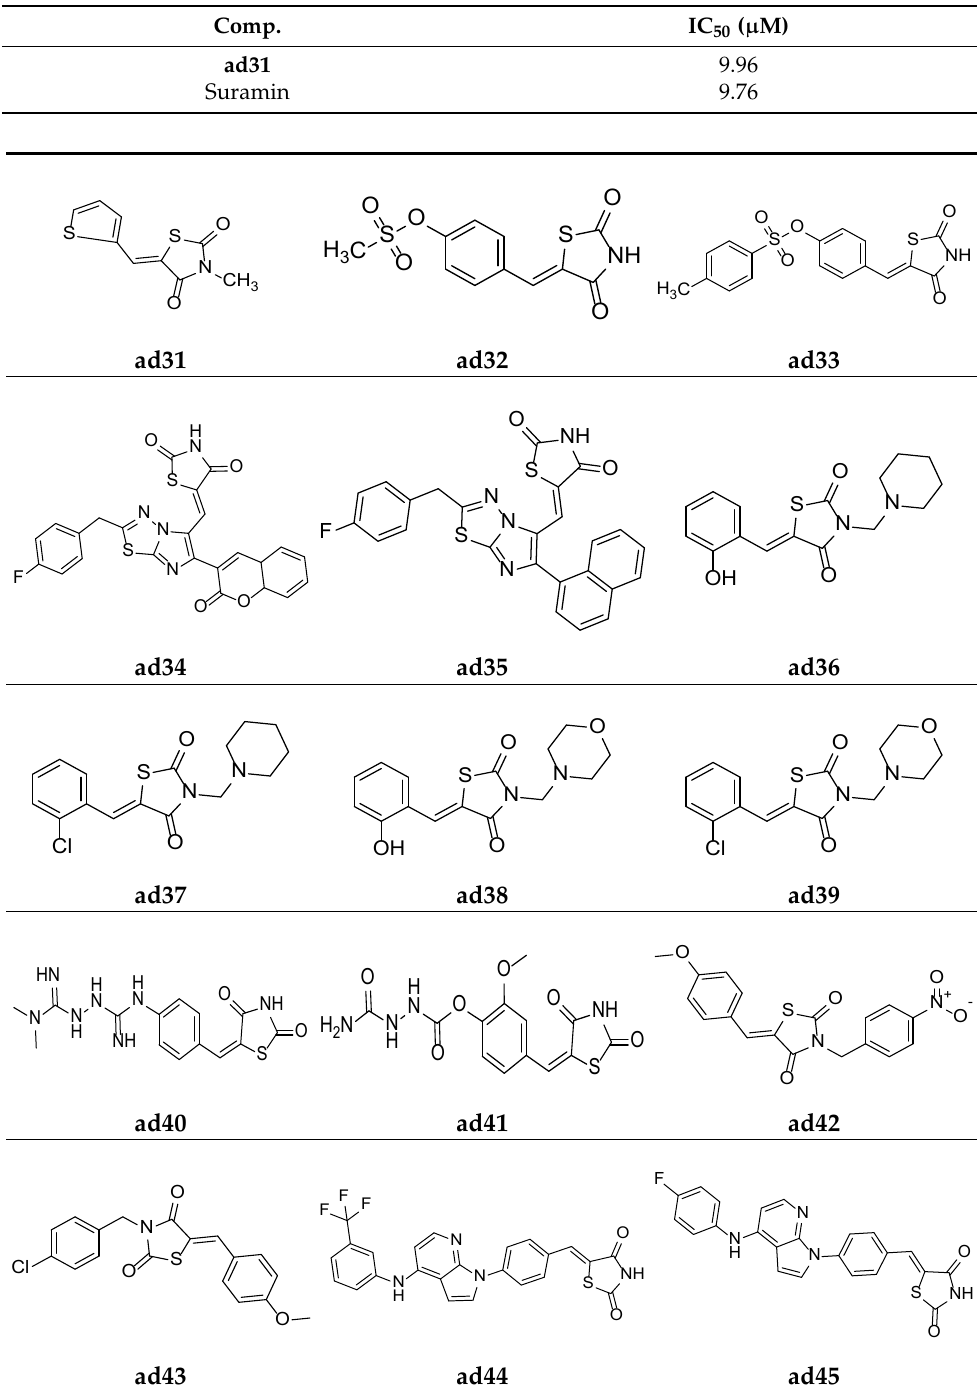
Table 43. Antidiabetic potential of compound ad31 using PTP1B inhibitory studies. Comp.